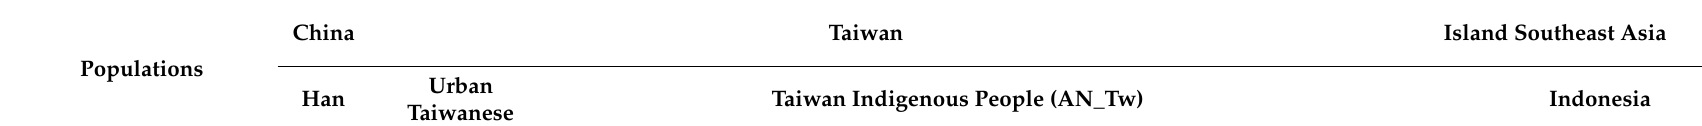
Table 2. Frequency table of NRY polymorphisms of the Northern Bunun and comparison with other